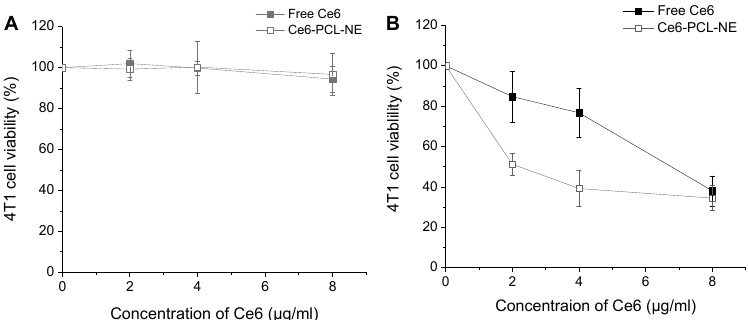
Figure 3. Dark toxicity test of Ce6-PCL-NE and in vitro photodynamic effect. Cell viability based on MTT assay ( A ) in the dark and ( B ) upon laser irradiation in 4T1 cells treated with free Ce6 and Ce6-PCL-NEs for 2 h. Results represent mean ± s.d. ( n = 6).